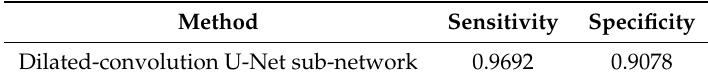
Table 6. Quantitative results of detecting nodule candidates from input chest CT images by the proposed